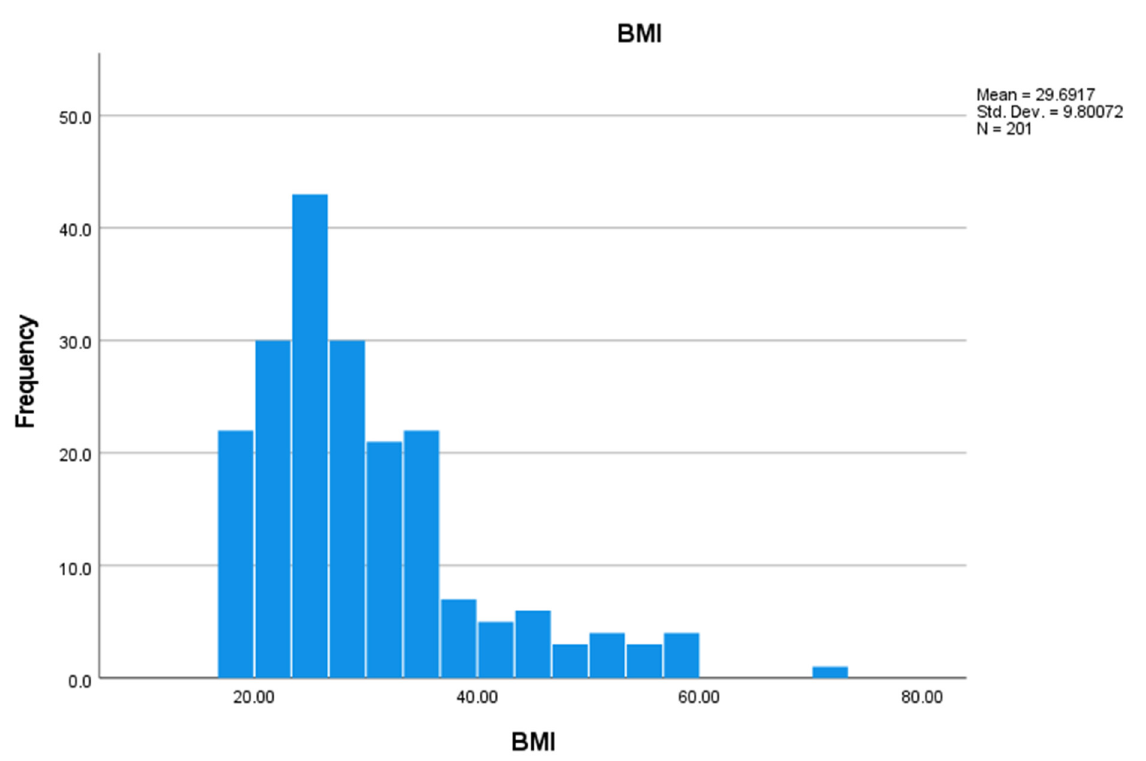
Figure 1. Education level of the interviewed population.